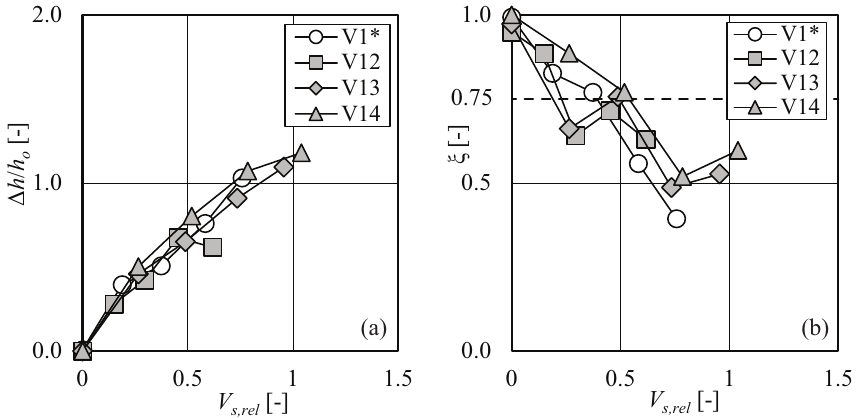
Figure 11. ( a ) Relative backwater rise ∆ h / h o and ( b ) bedload transport reduction factor ξ versus V s , rel for tests V1* (regular logs), V12 (logs with branches), V13 (25% RW ), and V14 (50% RW